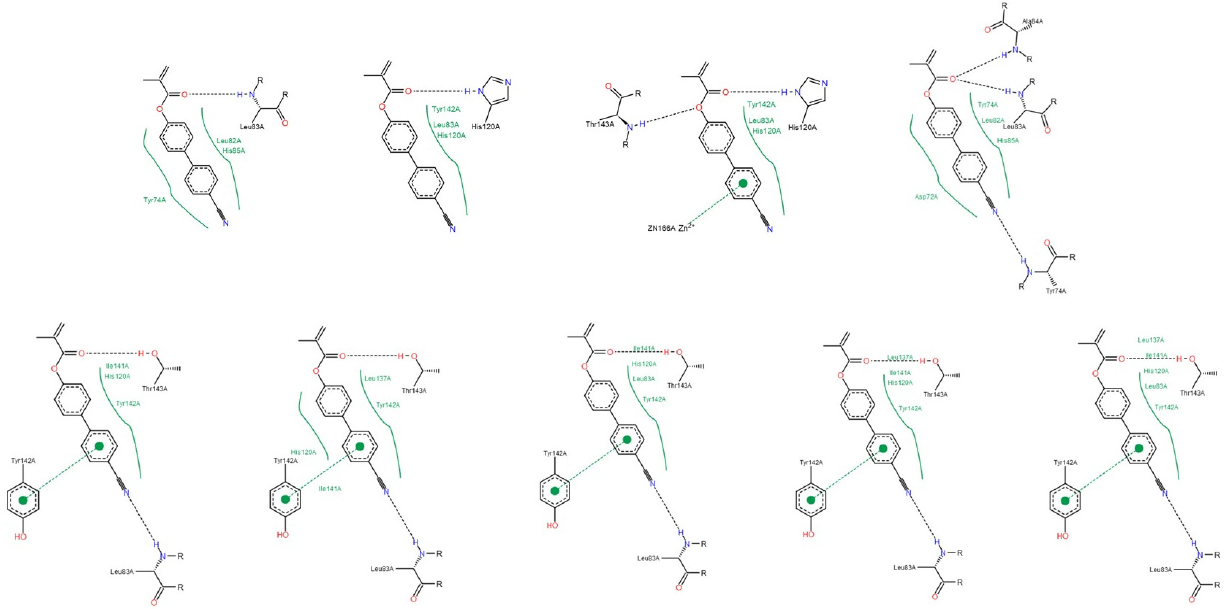
Figure A7. Interactions between compound A and MMP-2, by PoseView calculations.